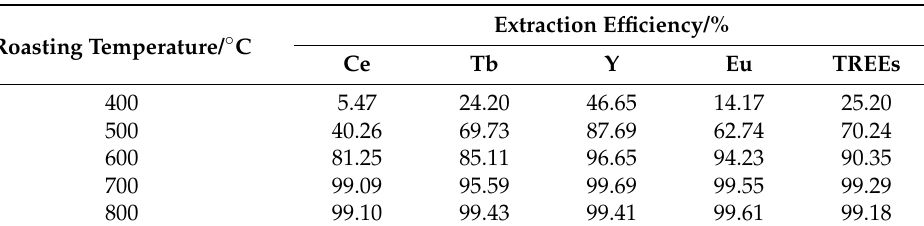
Table 3. Extraction efficiency of Ce, Tb, Y, Eu, and total rare earth under different roasting temperatures (oxygen concentration in the mixed gas of 0.4%, roasting time of 3 h, mass ratio of phosphor powder to alkali 1:3, HCl solution concentration of 8 mol·L −1 , acid leaching temperature of 60 °C , acid leaching time of 1 h, and liquid–solid ratio of 10:1.).